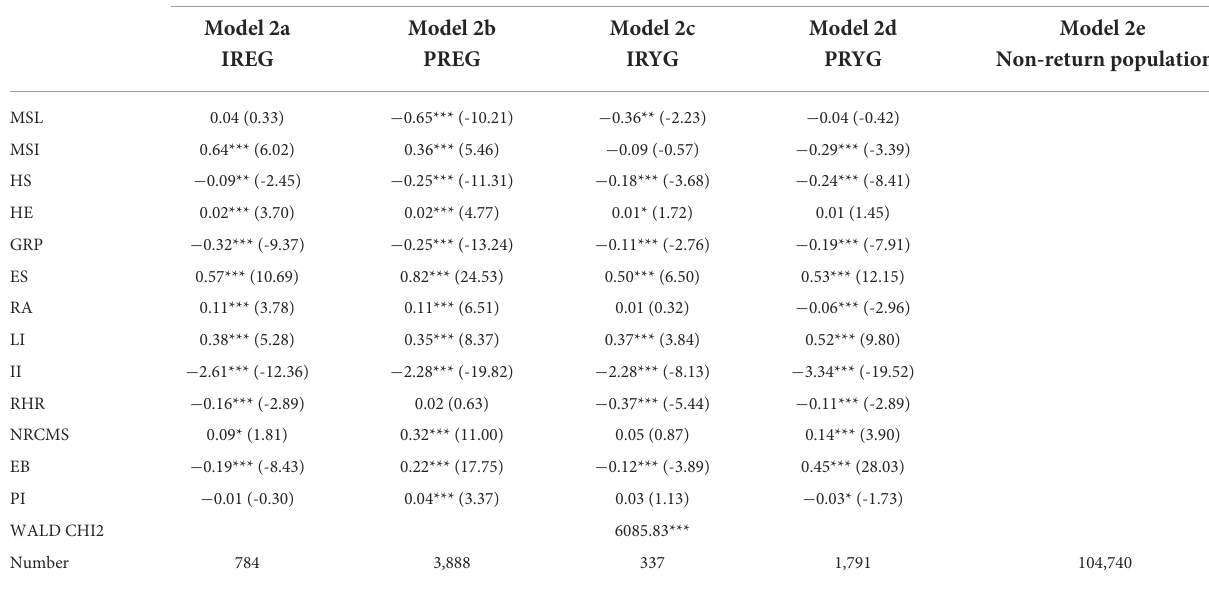
TABLE 5 Results table of multinomial Probit regression for different groups.